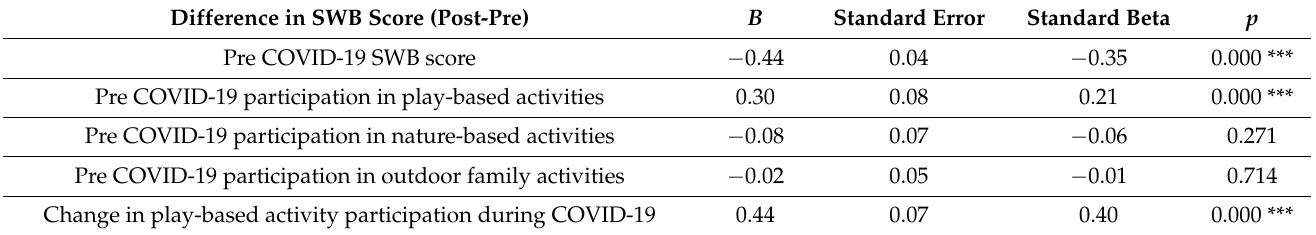
Table 5. Linear Regression depicting factors associated with change in subjective well-being scores pre and post COVID-19 for adolescents in the Unites States ( n =